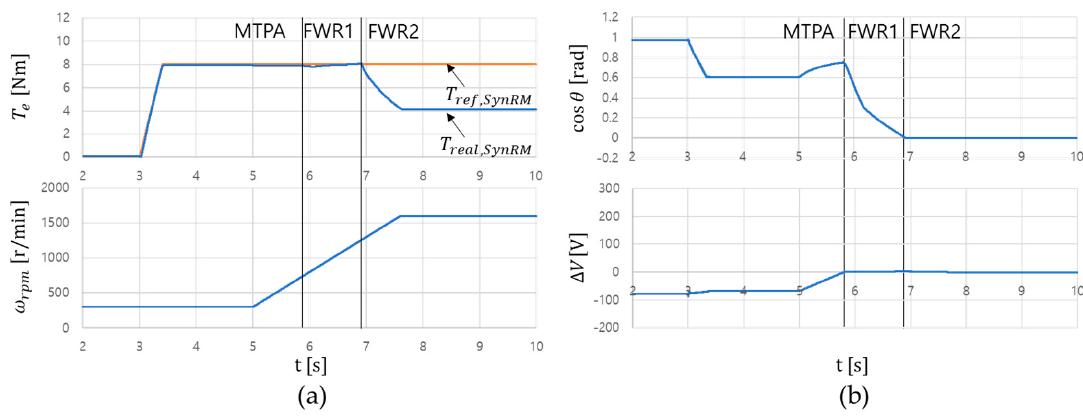
Figure 8. Simulation results with the apparent inductance of the self-axis flux saturation model: ( a ) simulation conditions and ( b ) operation of the proposed algorithm.